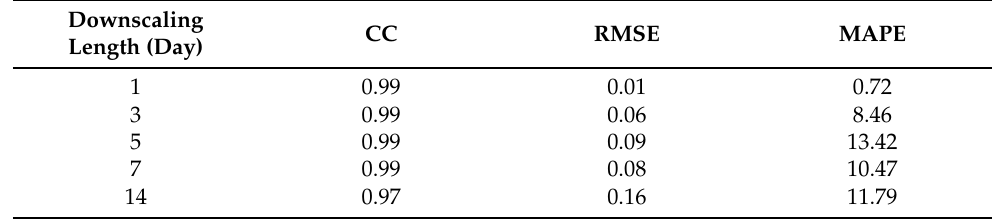
Table 7. Sensitivity of the downscaling prediction length with the resulting accuracy of downscaling.